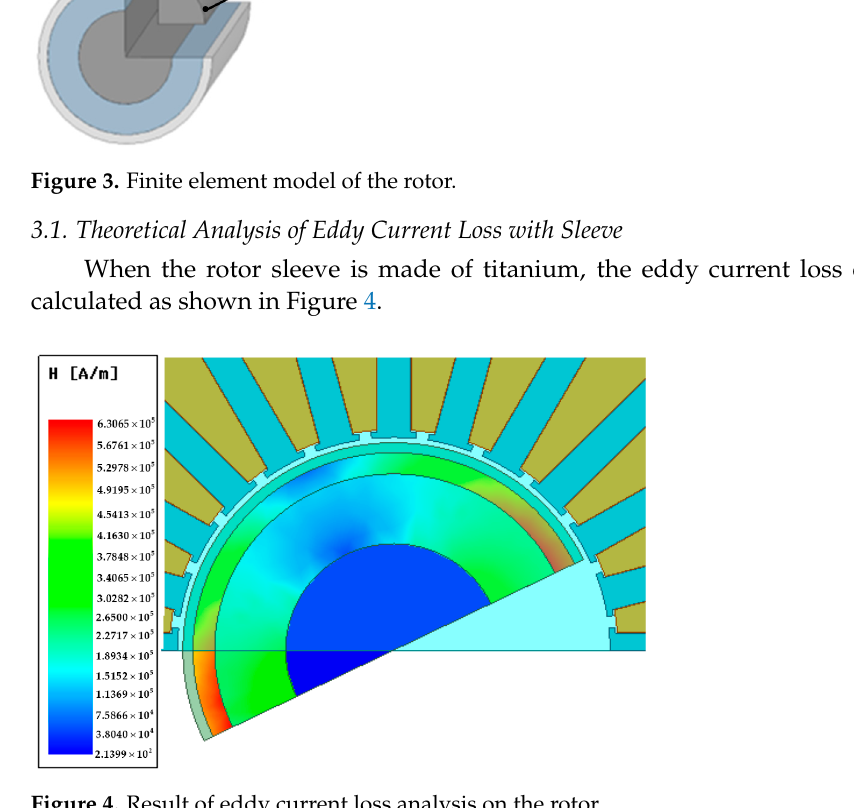
Figure 3. Finite element model of the rotor.